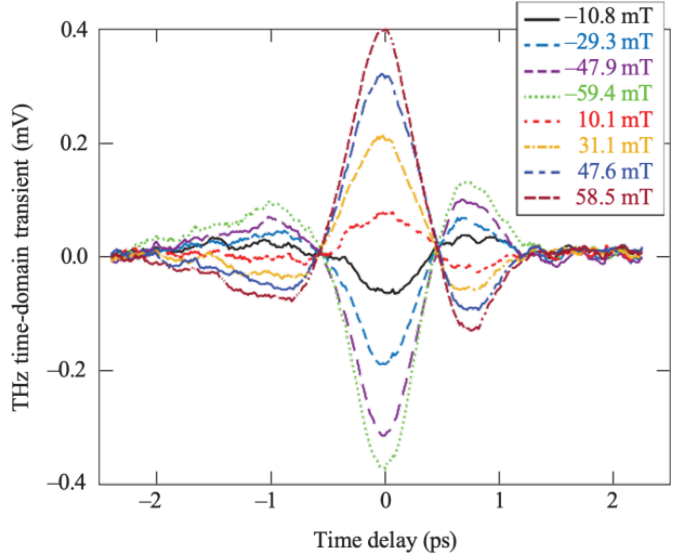
Figure 5. Amplitudes of THz transients emitted from a SI GaAs sample at different strengths of the external magnetic field with normal incident angle of the excitation beam and zero optical rectification. Results for other samples are not shown, but they exhibit the same behavior.